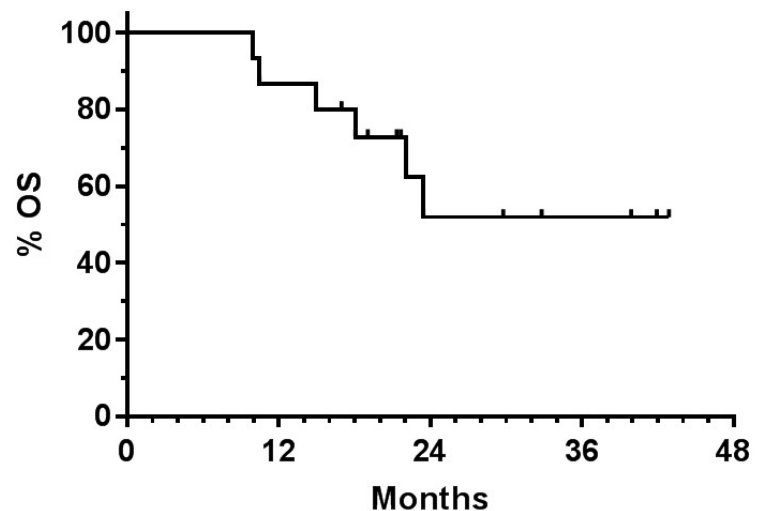
Figure 1. Patients with first diagnosis of primary GBM were treated with Standard therapy including multimodal immunotherapy. The details of the patients have been published (142). An updated overall survival curve of this cohort of patients, 14 months later, is presented. The difference to the earlier calculation is due to the later time point of analysis.